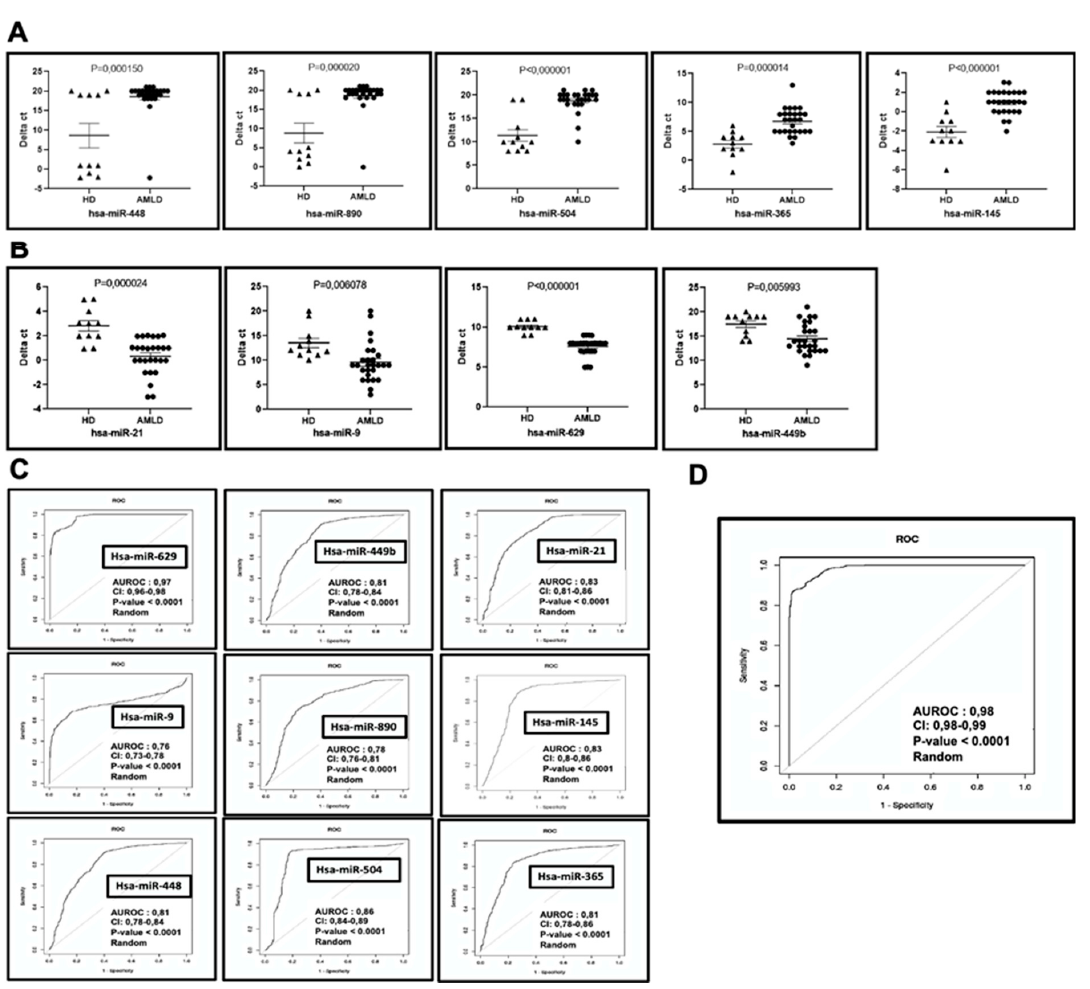
Figure 2. AML bone marrow circulating miRNA signature. The dot blot ( A , B ) and receiver operating characteristic (ROC) curves ( C , D ) reflecting the ability of the bone marrow circulating miRNA expression signature to differentiate the AML cases ( n = 27) from the controls ( n = 11). ( A ) Downregulated miRNAs: miR-448, 890, 504, 145, 365 and. ( B ) Upregulated miRNAs: miR-9; 21, 629 and 449b. ( C ) ROC curves reflecting the performance of the individual features of the 9 miRNA signature in discriminating AML patients from healthy donors. ( D ) Combined ROC showing the overall discriminatory power of the 9-miRNA signature. AUROC: Area Under ROC; CI: 95% Confidence Intervals; p -value: correspond to a Mann-Whitney U test addresses testing the null hypothesis of the AUROC is 0.5 (i.e., the classifier is random).